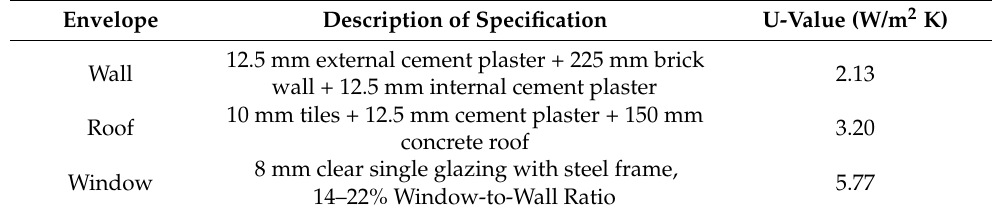
Table 1. Boundary conditions of building envelope components.